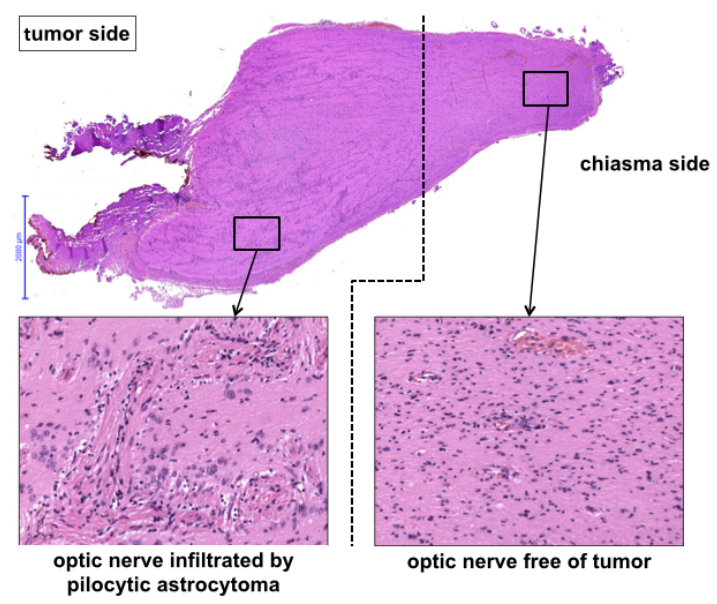
Figure 3. Histological view of the pre-chiasmatic tumor margin .